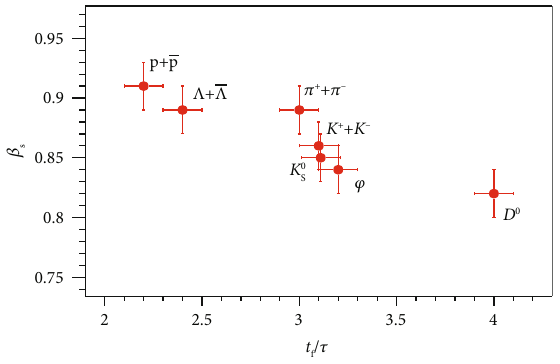
/ τ of various particles for versus t f ffiffiffiffiffiffiffiffi p s = 2 : 76TeV s NN